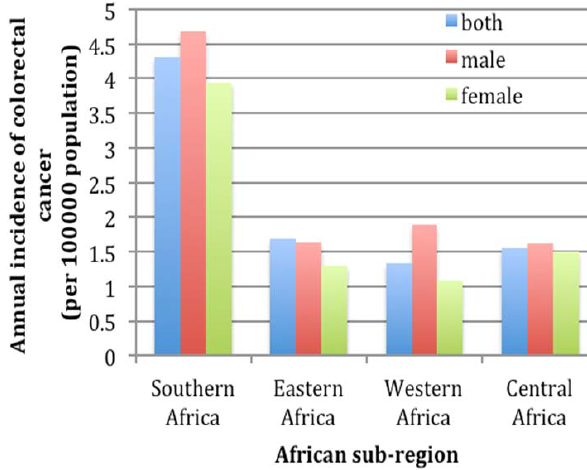
Figure 8 Annual crude incidence of colorectal cancer by African sub–region (per 100000 population).